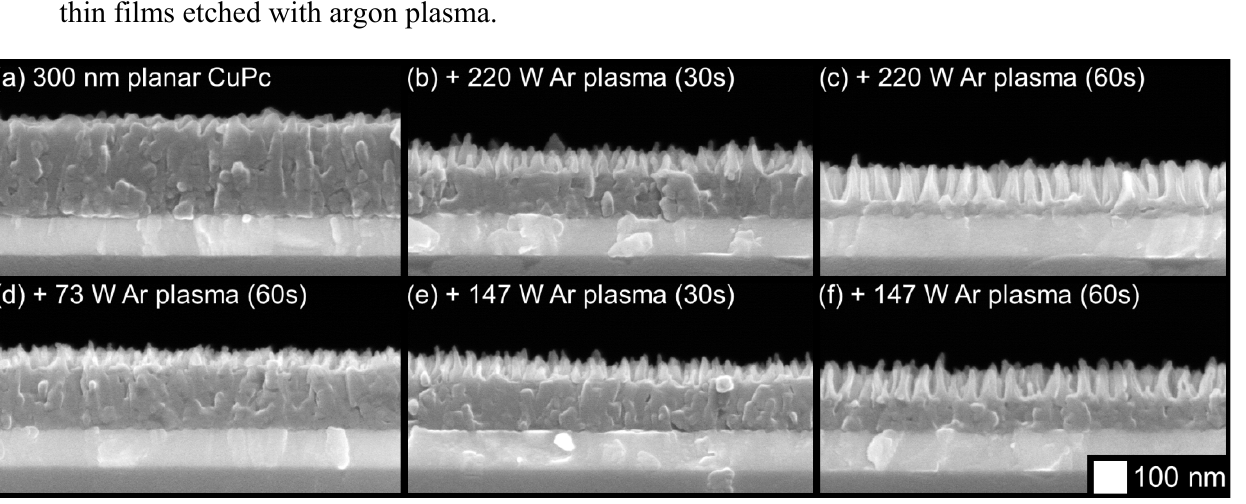
Figure 3. Effects of different etch conditions and etch times on the morphology of CuPc thin films etched with argon